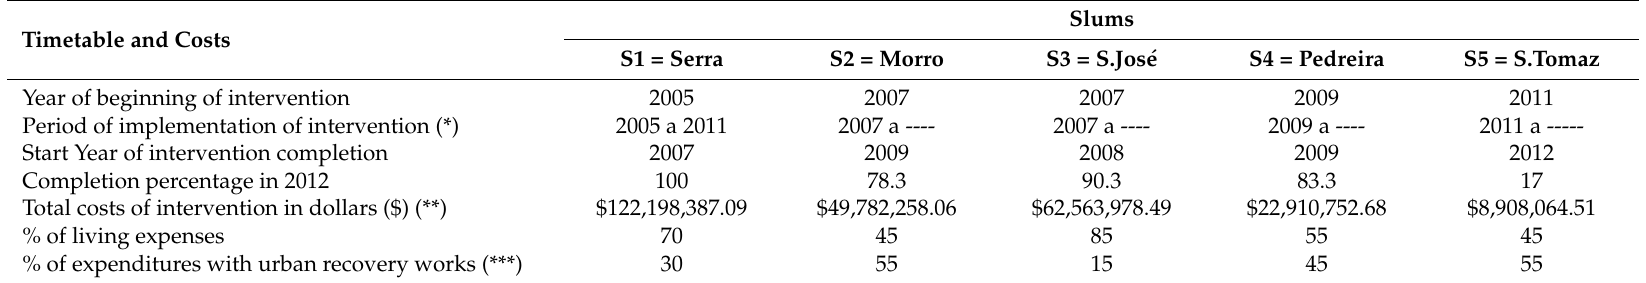
Table 2. Time of interventions and costs per works. Vila Viva Project, 2002 to